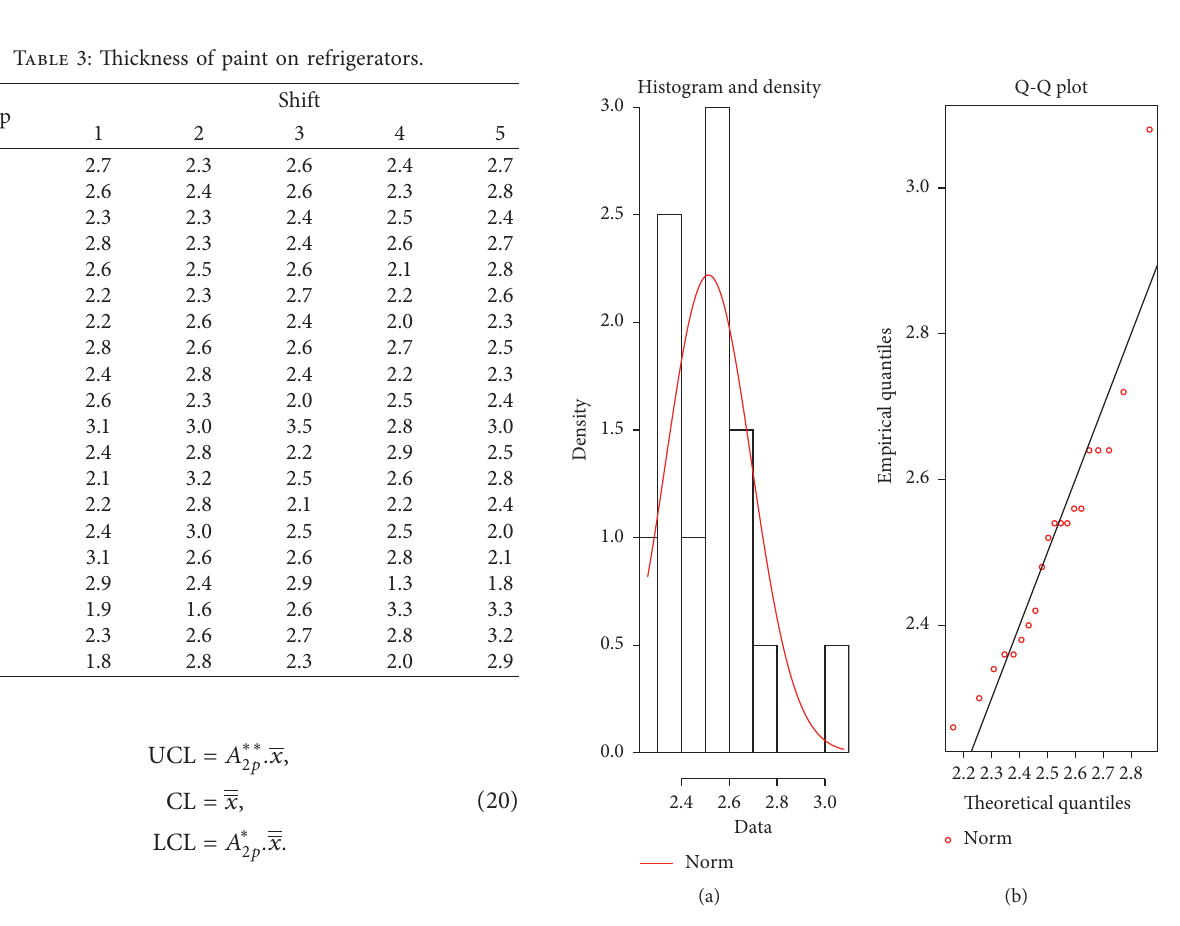
Figure 1: Density and Q-Q plots of the thickness of paint